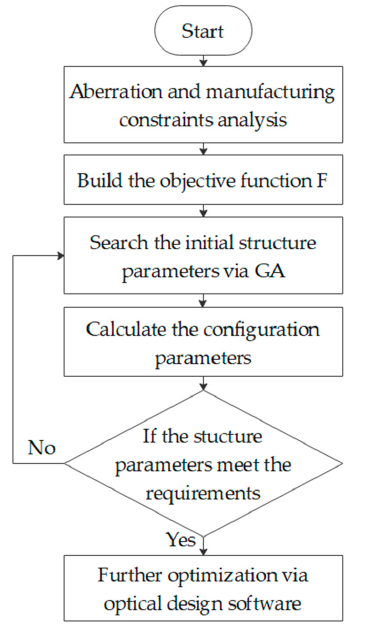
Figure 7. Flowchart of the design process.